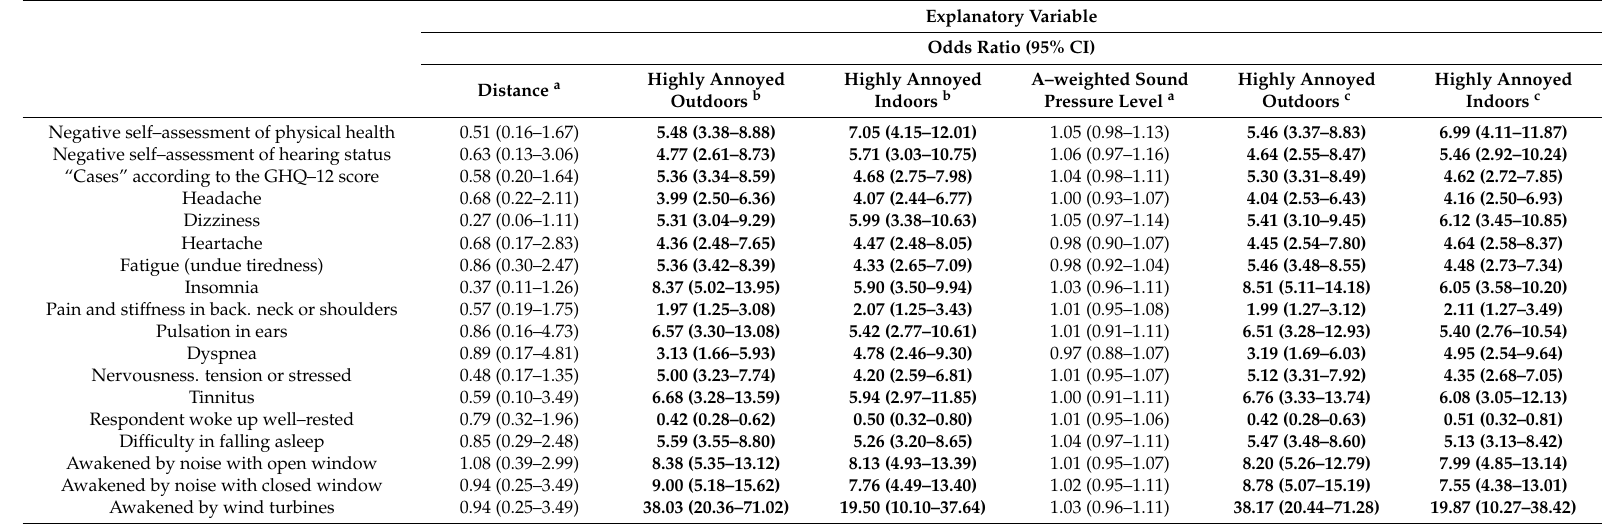
1 Statistically significant relationships are presented in bold numbers ( p < 0.05); a Adjusted for age and gender; b Adjusted for age, gender and distance from the nearest wind turbine; c Adjusted for age, gender and the calculated A-weighted sound pressure